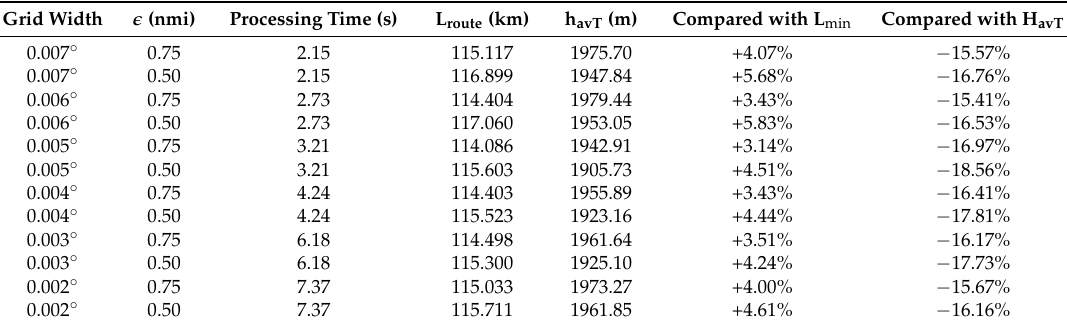
Table 5. Comparison of results with different granularity.